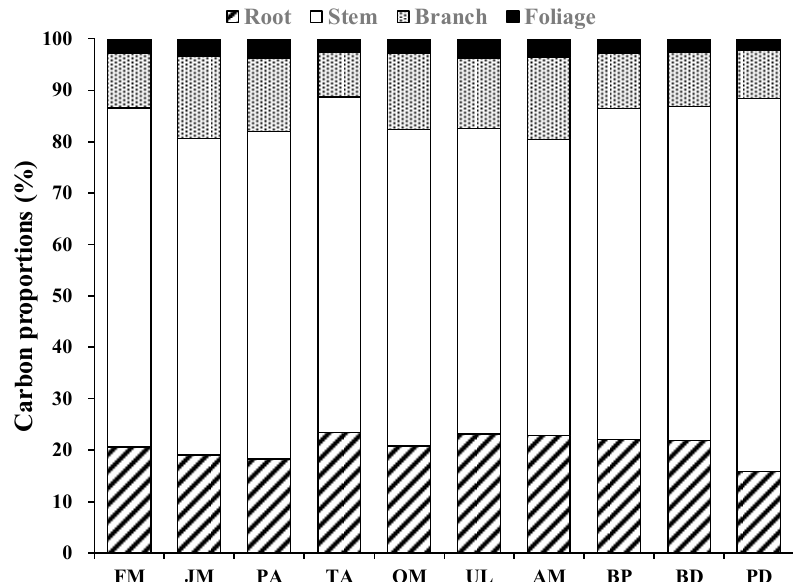
Figure 5. Distribution of aboveground and belowground carbon among different tree tissues (root, stem, branch, and foliage) for 432 trees from 10 tree species. FM: Fraxinus manshuric ; JM: Juglans mandshurica ; PA: Phellodendron amurense ; QM: Quercus mongolica ; TA: Tilia amurensis ; UL: Ulmus laciniata ; AM: Acer mono ; BP: Betula platyphylla ; BD: Betula davuria ; PD: Populus davidiana .